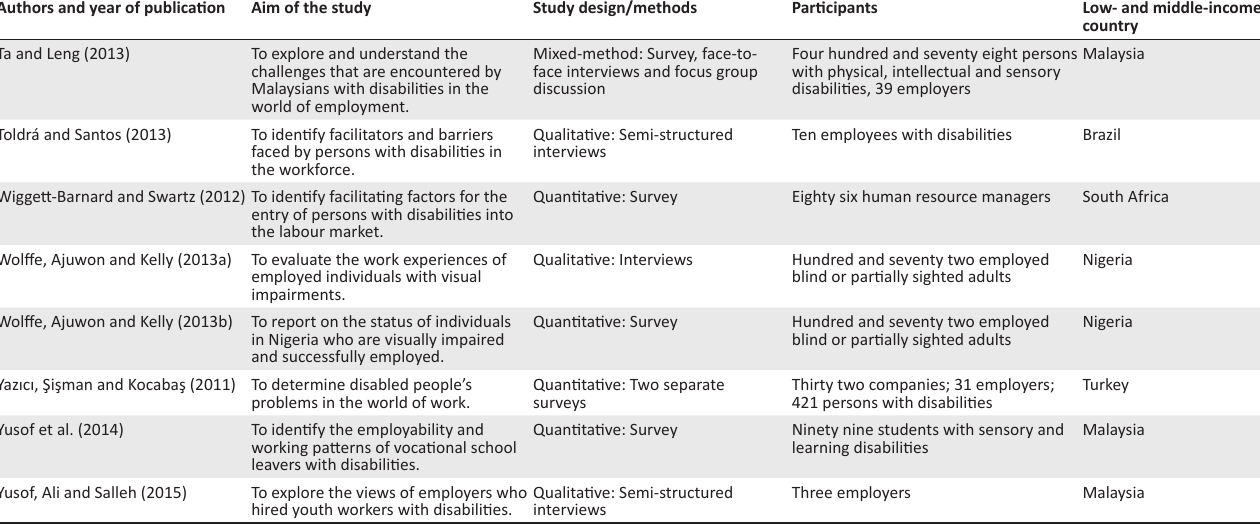
TABLE 2 (Continues...): Studies reporting on barriers and facilitators of employment of persons with disabilities in low- and middle-income countries.